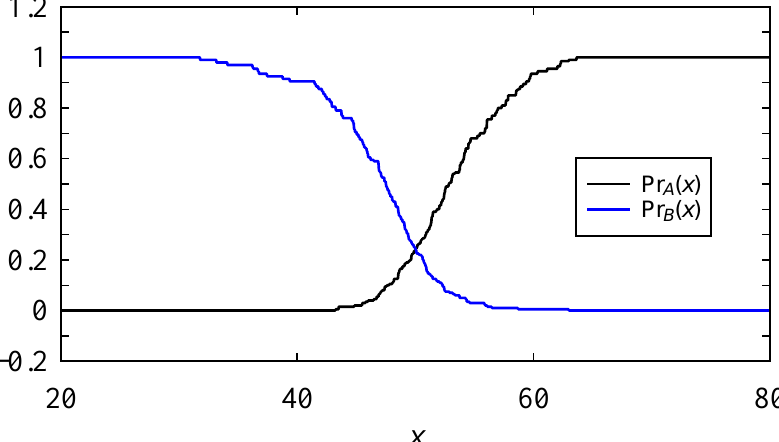
Figure A6. The typical nature of Pr A ( x ) and Pr B ( x ) for unimodal quantity.